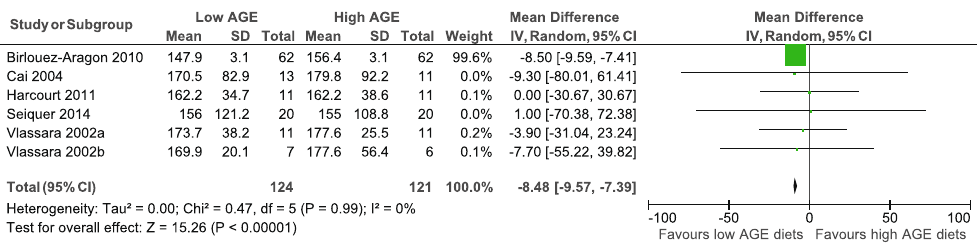
Figure 2. Meta-analysis of low AGE and high AGE diets for total cholesterol (mg/dl): forest plot shows the effect of low AGE and high AGE diets on total cholesterol.